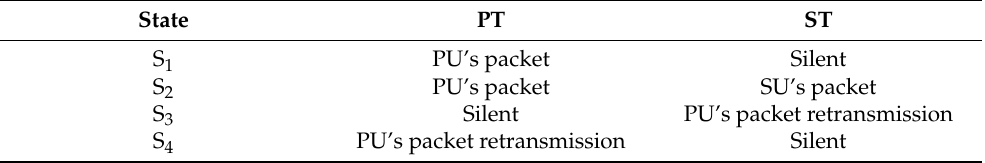
Table 2. Hybrid cooperative cognitive radio networks based on pure OMA of transmission state. State PT ST S 1 PU’s packet Silent S 2 PU’s packet SU’s packet S 3 Silent PU’s packet retransmission S 4 PU’s packet retransmission